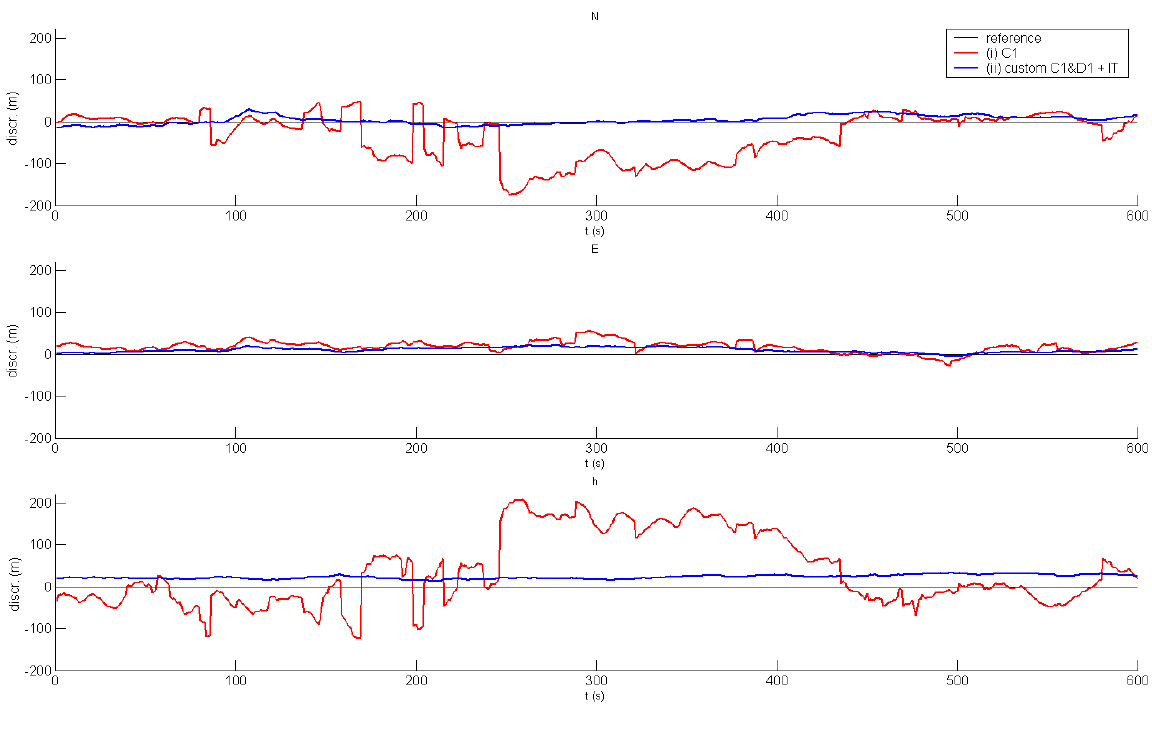
Figure 5 . The best and worst indoor solutions: (i) autonomous C1 positioning; (ii) custom positioning procedure with C1&D1, plus ionosphere and troposphere models.